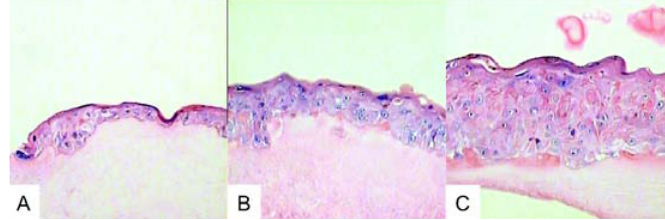
FIGURE 2 - Air-liquid interface culture situation (Light microscopy,